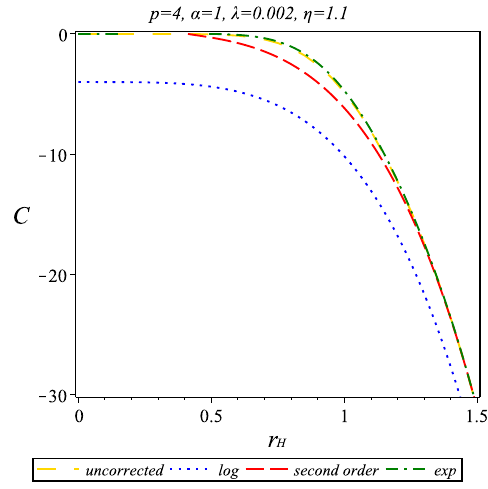
Figure 2 . Specific heat in terms of horizon radius for β = 1 and ω 0 = 1